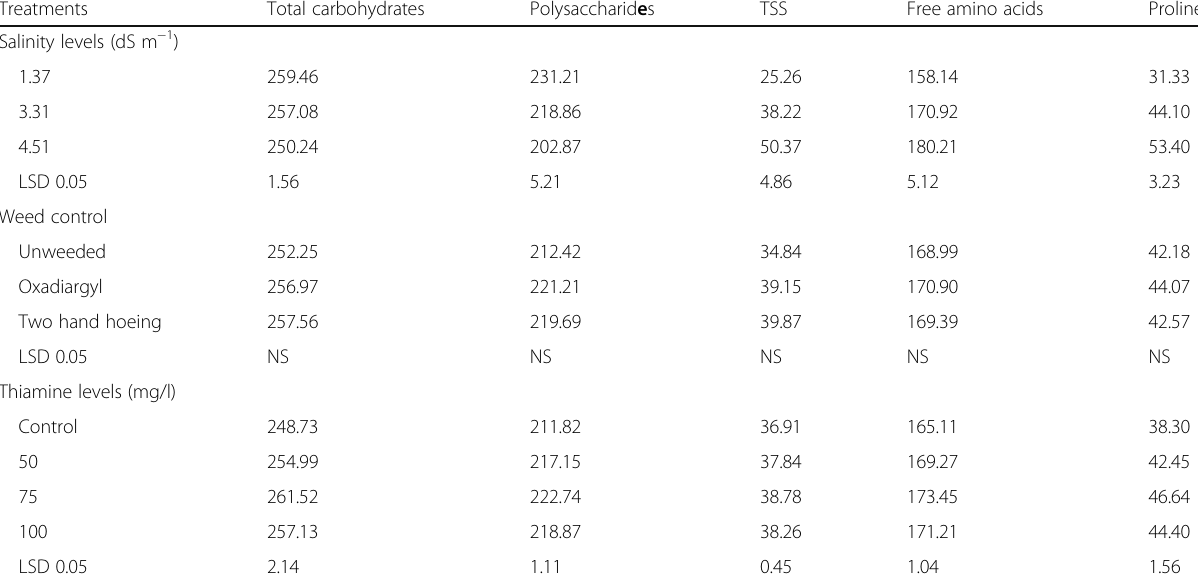
Table 4 Effect of weed control and thiamine treatments on carbohydrates constituents (mg/g dry wt), free amino acids, and